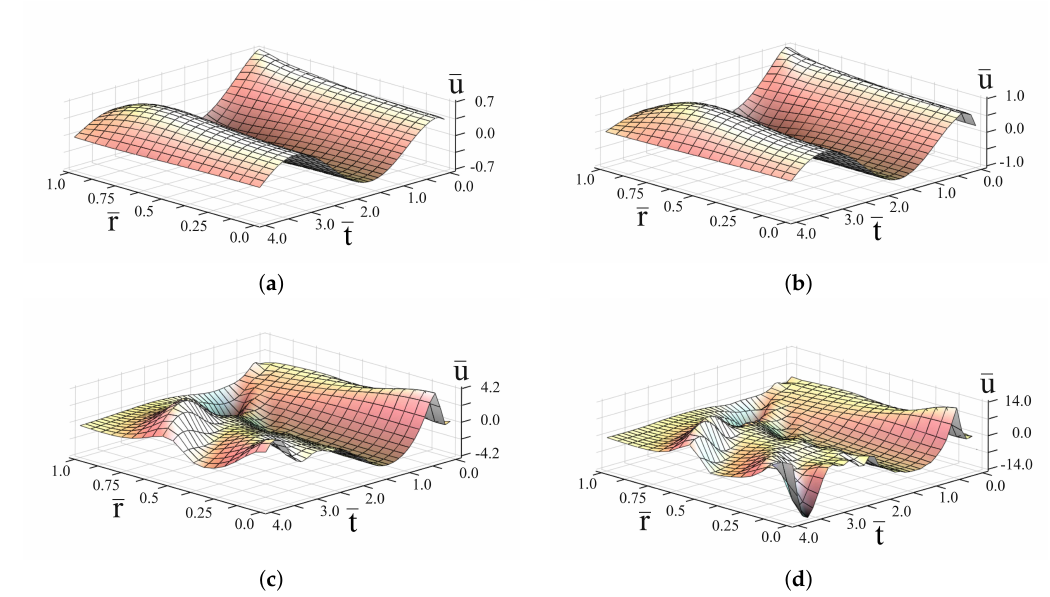
Figure 5. Evolution of the solution for the problems (12)–(15) for different orders of fractional derivative. The results of computer simulation of the formula (27) for the parameters ¯ b = 2, ¯ ω = 2.0 and different values of α : α = 0.75—( a ); α = 0.95—( b ); α = 1.75—( c ); α = 1.95—( d